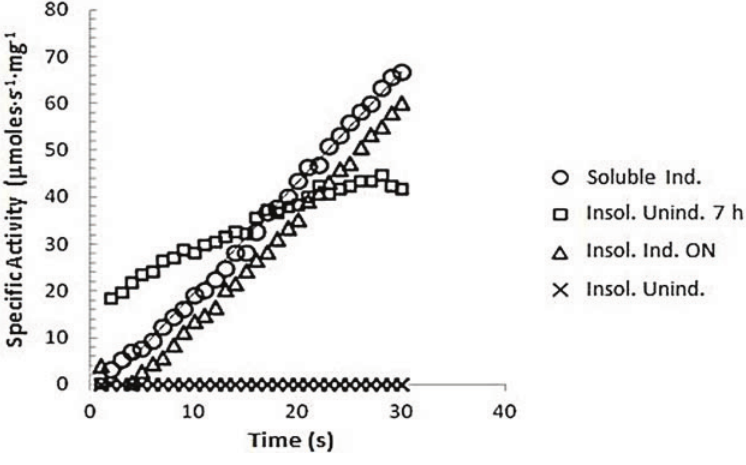
Figure 5. GPpNA assay of recombinant spPEP. The buffer was exchanged with 50 mM Tris, pH 8.0, containing 0.1 M NaCl for both the induced and uninduced soluble and inclusion body lysates. The reactions were started by the addition of 100 μL of 3 mM GPpNA to 100 μL of lysate. The A 410 was converted to specific activity (μM·s (cid:4)1 ·mg (cid:4)1 of total protein) for the respective sample using a (cid:3) 410 = 8,800 L·mol (cid:4)1 ·cm (cid:4)1